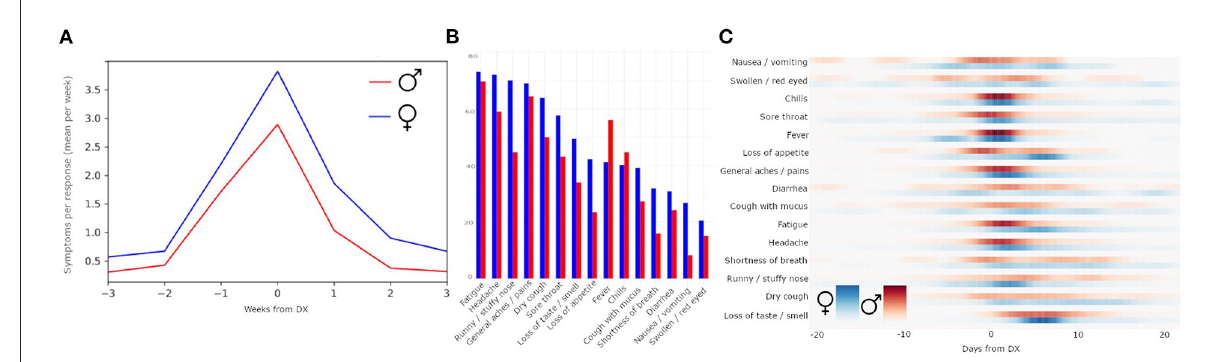
FIGURE3 Sex differences in symptom reporting. Within individuals reporting COVID-19 diagnosis, females have a higher average mean symptom rate than males (A) . Comparison by individual symptoms reported (B) shows that symptom prevalence is not identical across sexes. The probability distribution of the peaks of symptoms relative to DX date, separated by females (blue) and males (red) (C) .